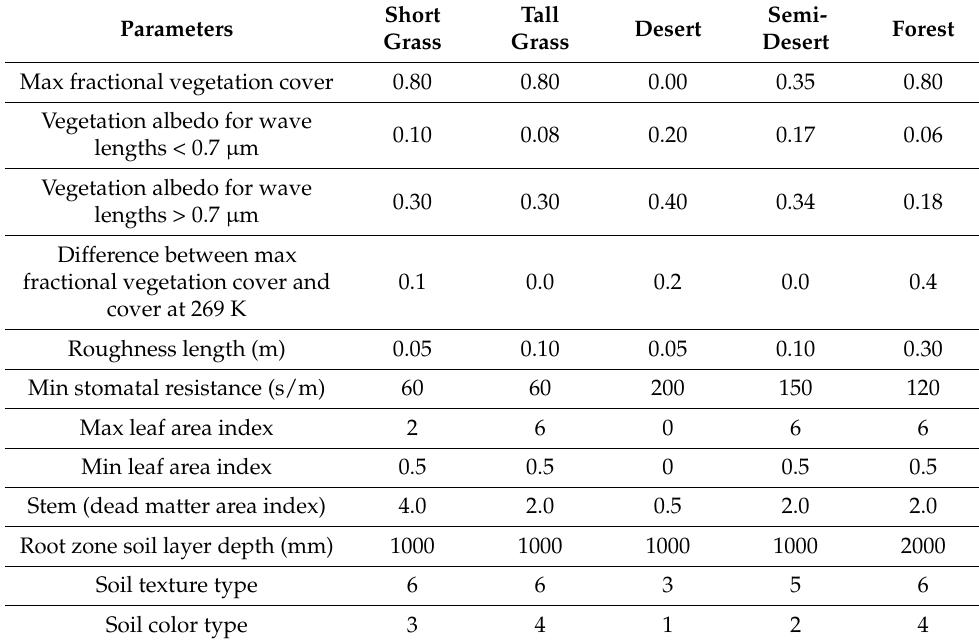
Table 2. Summary of BATS land cover characteristics used in the study. See Dickinson et al. [56] for more details.